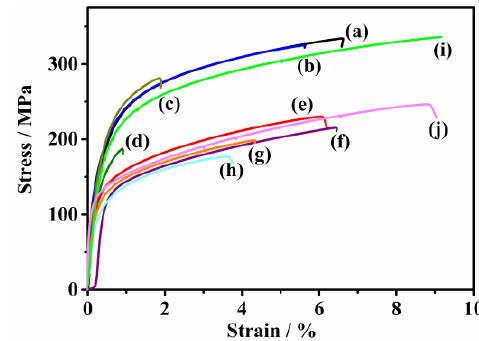
Figure 3. Tensile stress-strain curves of the sintered Fe–28Mn-based alloys immersed in SBF solution for various durations: ( a ) Fe–28Mn-3Si alloys immersed for 15 days; ( b ) Fe–28Mn-3Si alloys immersed for 30 days; ( c ) Fe–28Mn-3Si alloys immersed for 45 days; ( d ) Fe–28Mn-3Si alloys immersed for 60 days; ( e ) Fe–28Mn alloys immersed for 15 days; ( f ) Fe–28Mn alloys immersed for 30 days; ( g ) Fe–28Mn alloys immersed for 45 days; ( h ) Fe–28Mn alloys immersed for 60 days; ( i ) Fe–28Mn-3Si alloys with no immersion; ( j ) Fe–28Mn alloys with no immersion.